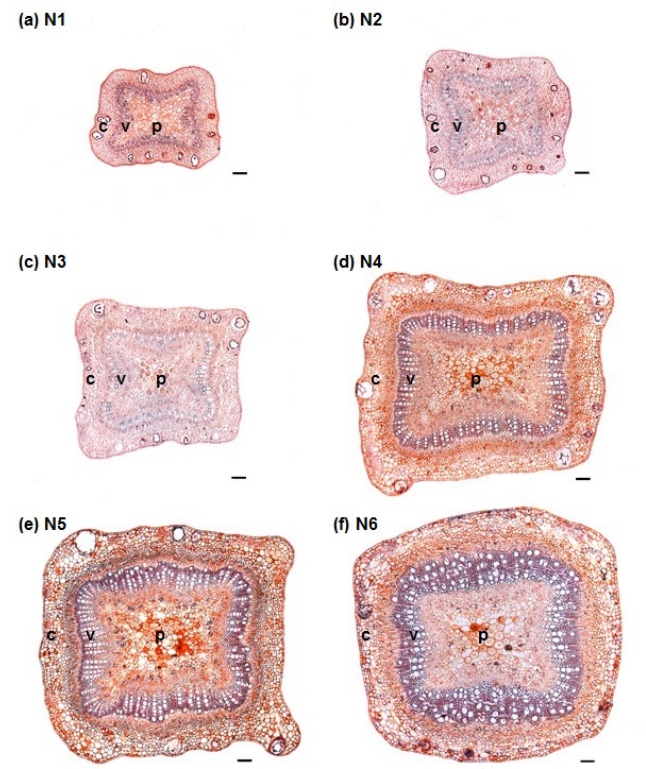
Figure 2. Transverse sections from the stem of cuttings from near node 1 (“N1”: the apical cutting) to node 6 (“N6”: the most basal cutting) of Eucalyptus grandis stock plants ( a – f) . c = cortex; v = vascular tissue; p = pith. Scale bars = 100